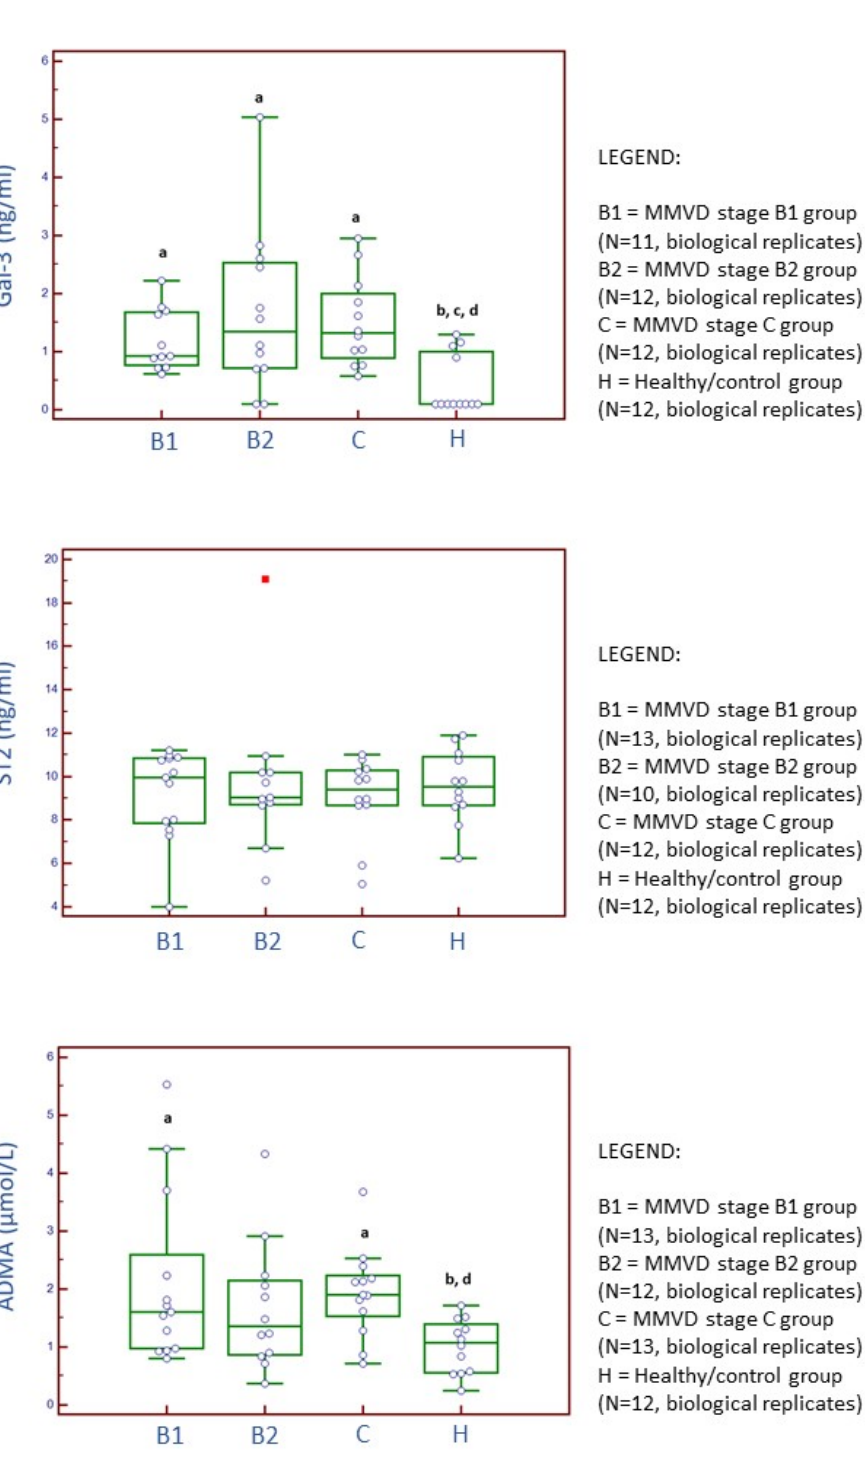
Figure 1. Distribution of serum concentrations for galectin-3 (Gal-3) ( a ), suppression of tumorigenicity 2 (ST2) ( b ), and asymmetric dimethylarginine (ADMA) ( c ) candidate cardiac biomarkers across three stages of naturally occurring myxomatous mitral valve disease (MMVD) and in healthy dogs. N represents the number of serum samples (biological replicates). a Statistically significantly different from control; b statistically significantly different from the MMVD stage B1; c statistically significantly different from the MMVD stage B2; d statistically significantly different from the MMVD stage